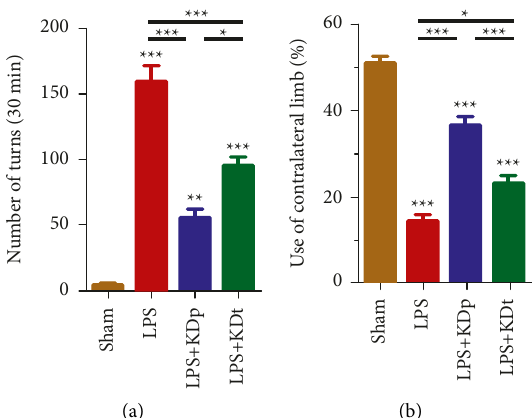
Figure 1: Dopamine deficient behavior test results of all groups. Data were presented as the mean ± SEM in APO-induced rotation test (a) and cylinder test (b). ∗∗∗ P < 0 . 001; ∗∗ P < 0 . 01; ∗ P < 0 . 05; LPS, lipopolysaccharide; KDp, preventive intervention with KD prior to the PD onset; KDt, therapeutic intervention with KD after the PD